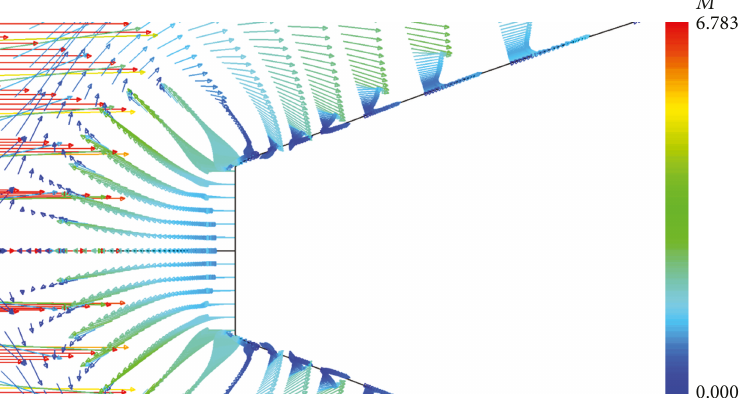
Figure 17: Gasjet model, blowing at fl at nose 0.91kg/S, Re = 4 3 × 10 6 , α = 0 0 ° , M = 6 8 .